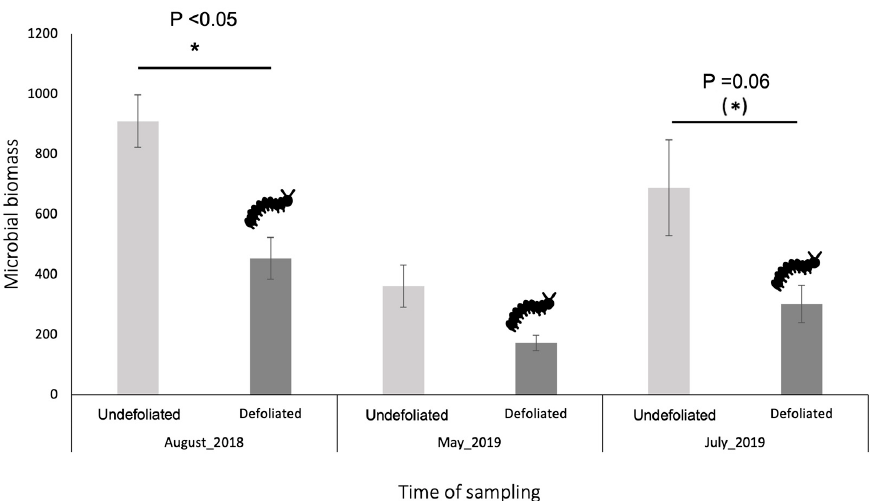
Figure 1. Mean microbial biomass (µg microbial-C g − 1 ) ± standard error from glucose-induced respiration of the top 5 cm of soil sampled under undefoliated (N = 8, 6, 6) and defoliated (N = 7, 5, 7) Populus tremuloides trees. Tukey’s test found the difference was significant in August 2018, not significant in May 2019, and marginally significant in July 2019. Soils were sampled in August 2018, May 2019 and July 2019 in the Lake Duparquet Research and Teaching Forest (Abitibi, QC, Canada). * p < 0.05 indicates a significant or (*) p = 0.06 a marginally significant post hoc Tukey contrast.